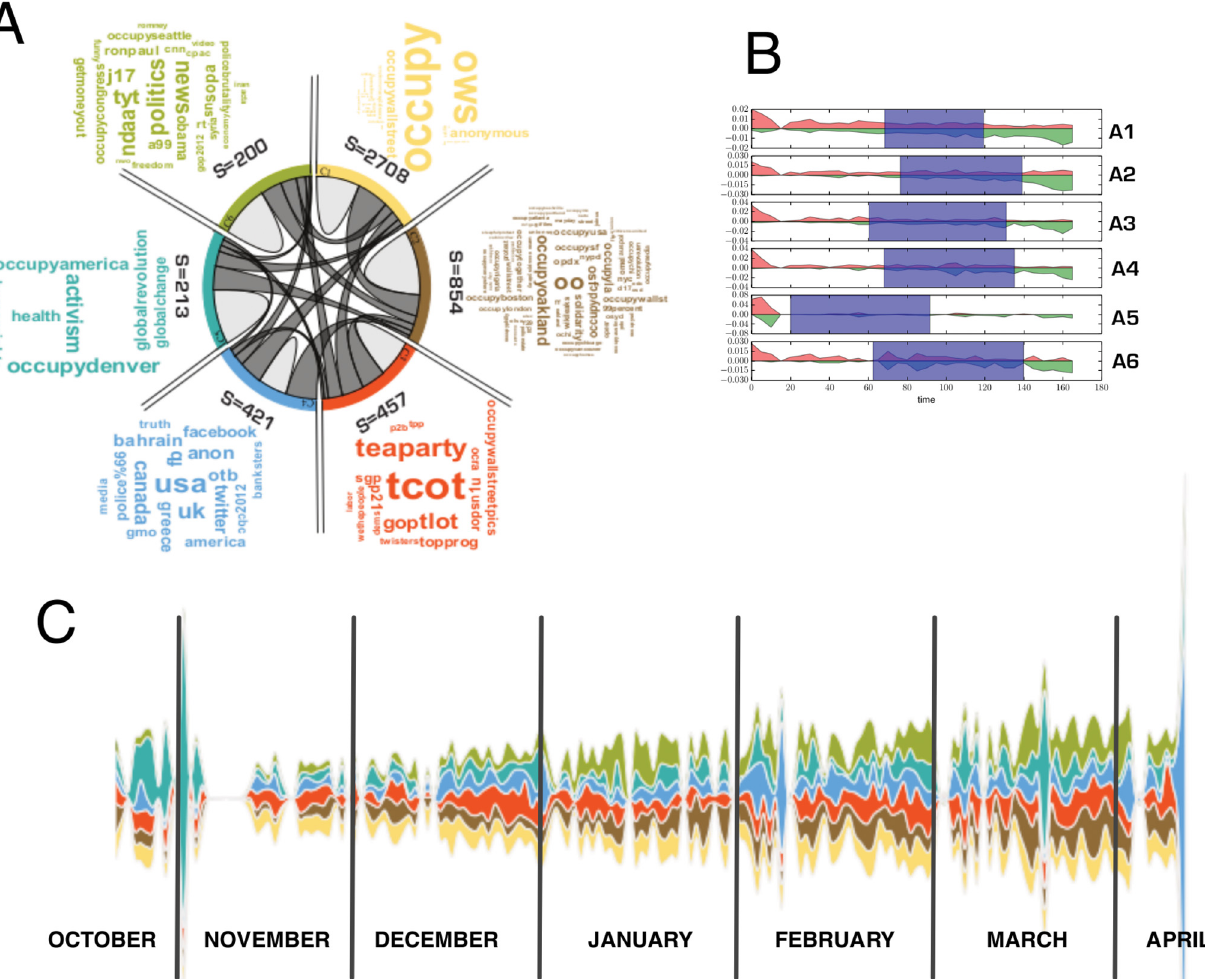
Fig 3. Communities description of the semantic network. The semantic network can be divided in 6 communities. Plot A: chord diagram representing the interactions among communities and their strengths. The grey bands represent links among communities member and their width is proportional to the number of connections between the two. Plot B: the permanence time of hashtags in the communities. The red histograms indicate the fraction of hashtags entering the community, for the first time, at a specific time; the green one the leaving time. The shaded area corresponds to the average permanence time of the community contents. Plot C: steamgraph showing the relative activity of the communitiesat time t. The relative importance of the community at time t is evaluated as the number of tweets contacting at least one of the community ahshtags normalized tot toal number of tweets collectd at time t. For each day, the height of the band corresponds to the proportion of activity of each community (number of tweets) normalized to the total activity. The color code is the same as in plot A and each band in the stream graph corresponds to a specific community (C1 in the bottom,C6 on top).